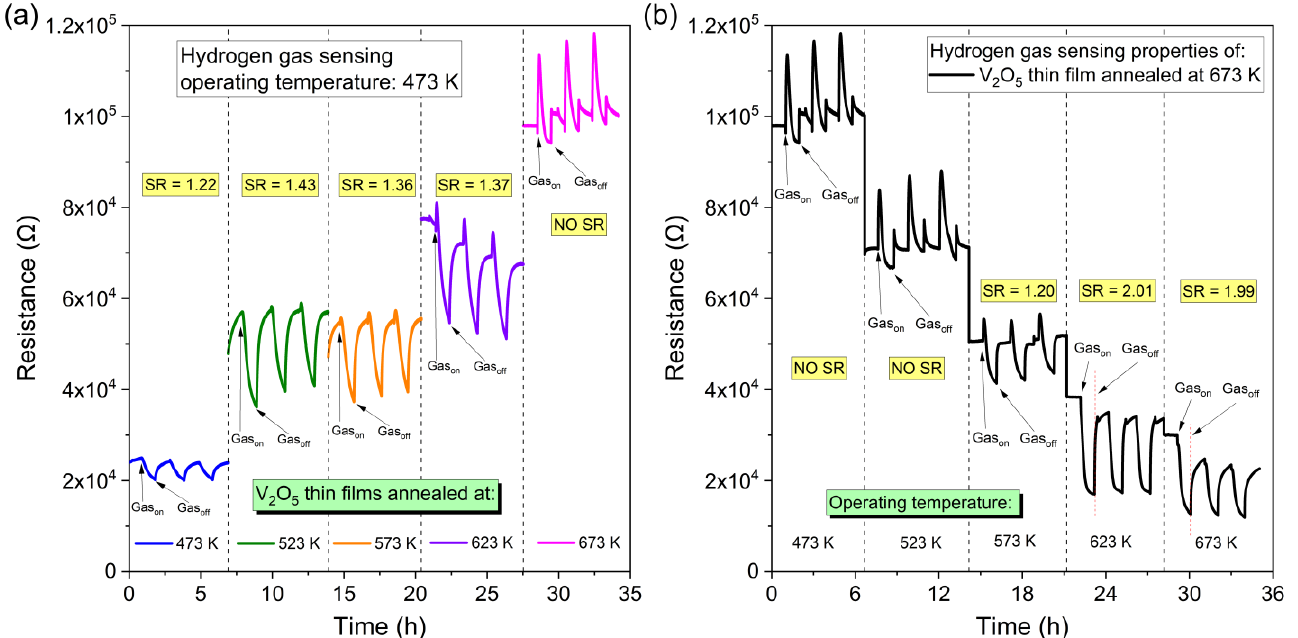
Figure 10. Electrical resistance changes upon exposure to diluted hydrogen (3.5% in Ar) of V 2 O 5 thin films: ( a ) annealed at various temperatures and measured at operating temperature of 473 K and ( b ) annealed at 673 K and measured at various operating temperatures.